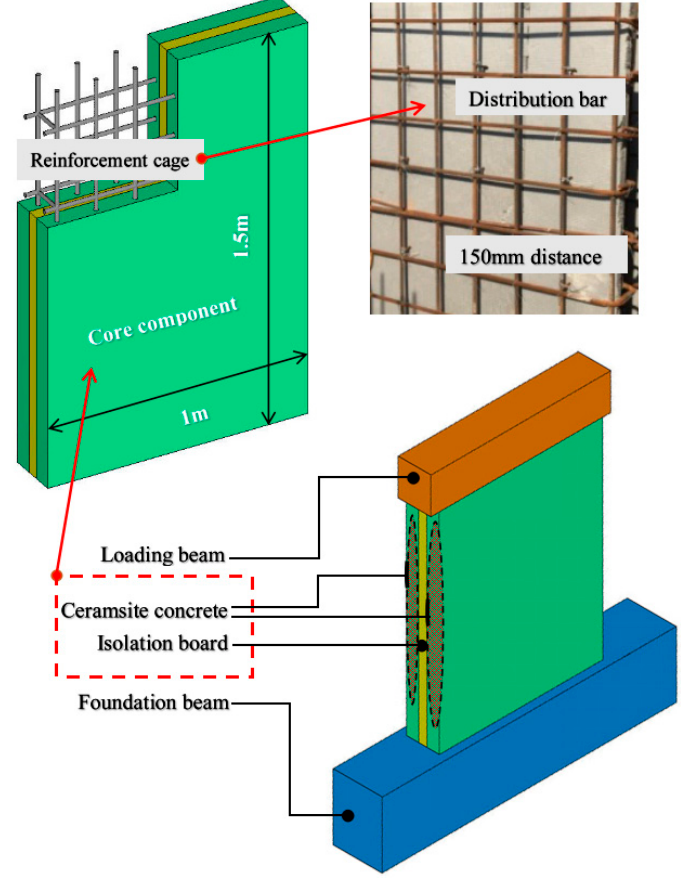
Figure 2. Schematic diagram of three-dimensional model of